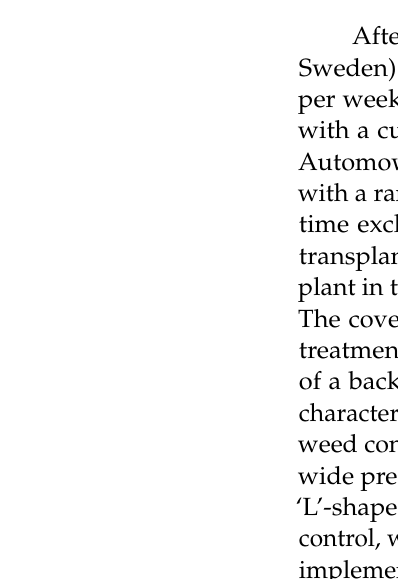
Table 1. List of operations carried out during the trial for TILL, LM-FL, and LM-AM plots. Operation